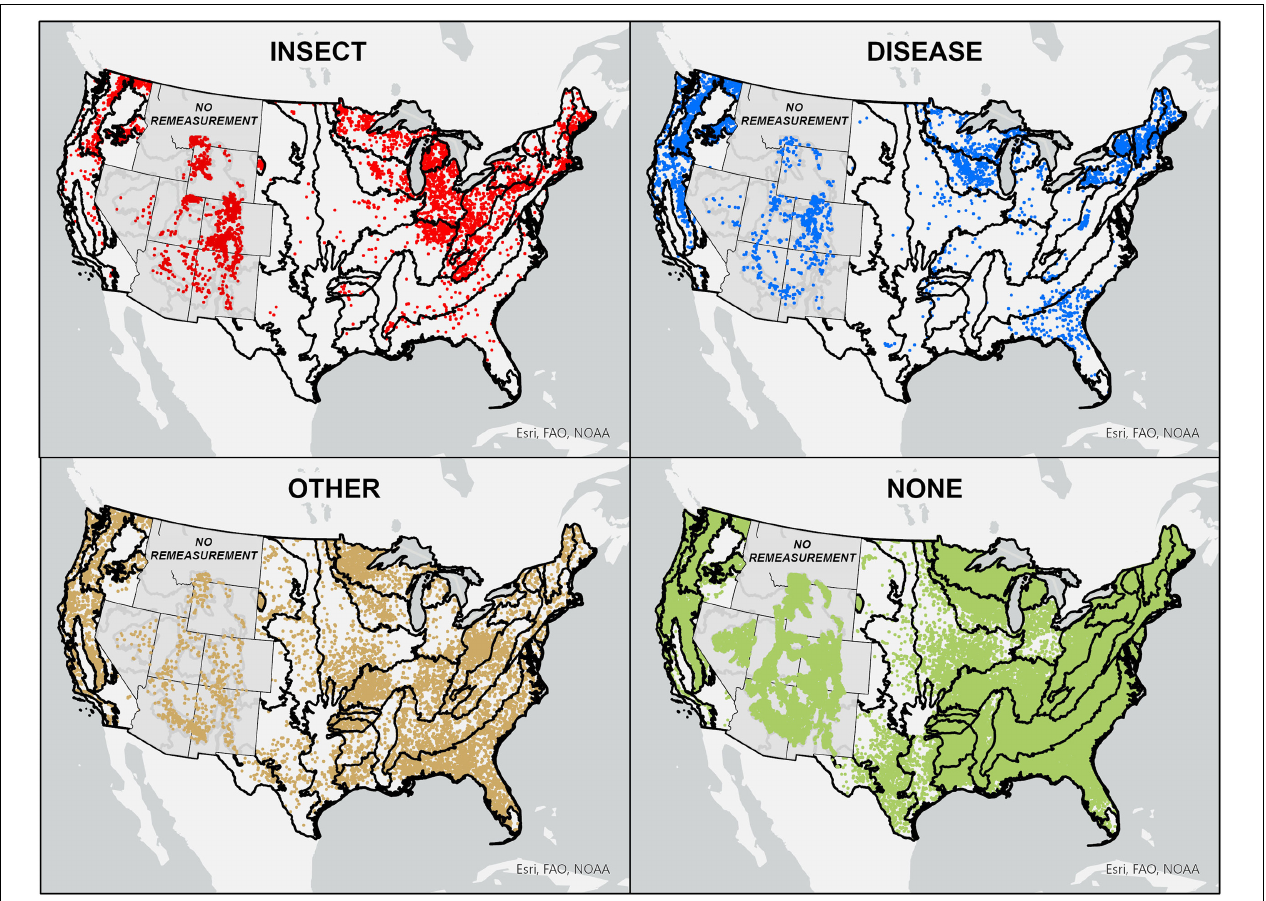
FIGURE 1 | Approximate locations of NFI plots by dominant disturbance type assigned to each NFI plot across contiguous US. Black lines delineate ecoprovince boundaries. Grayed out states (i.e., Rocky Mountain states) contain NFI plots having only one recent live tree C measurement that prohibited their inclusion in our analysis of average annual change in live tree C sequestration